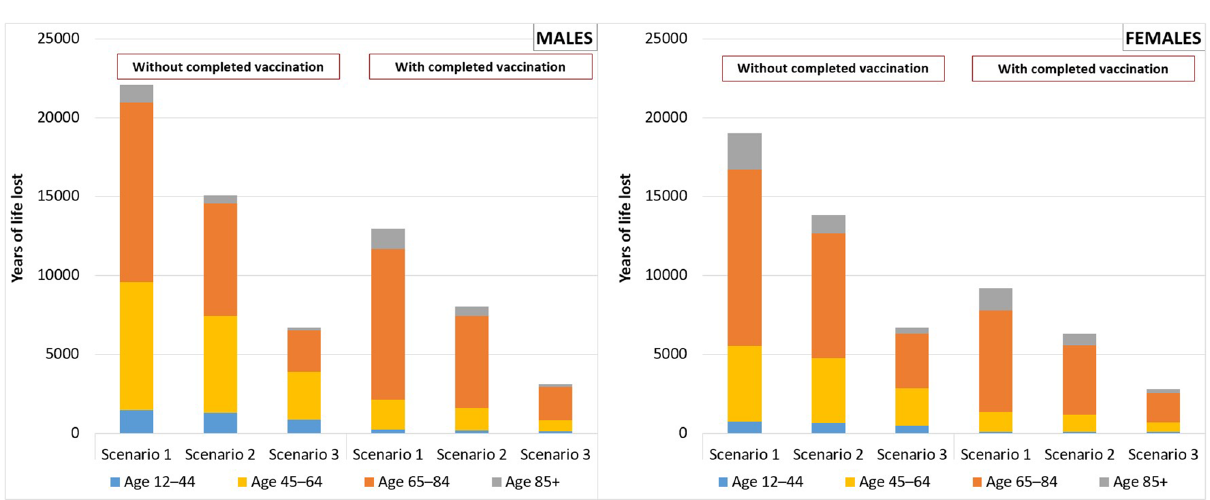
Figure 3. Years of life lost (YLL) by males, females, population with or without completed vaccination, and Scenarios 1–3 during the period of October 1 to December 31, 2021, Czechia. Source: author’s calculation 11,15